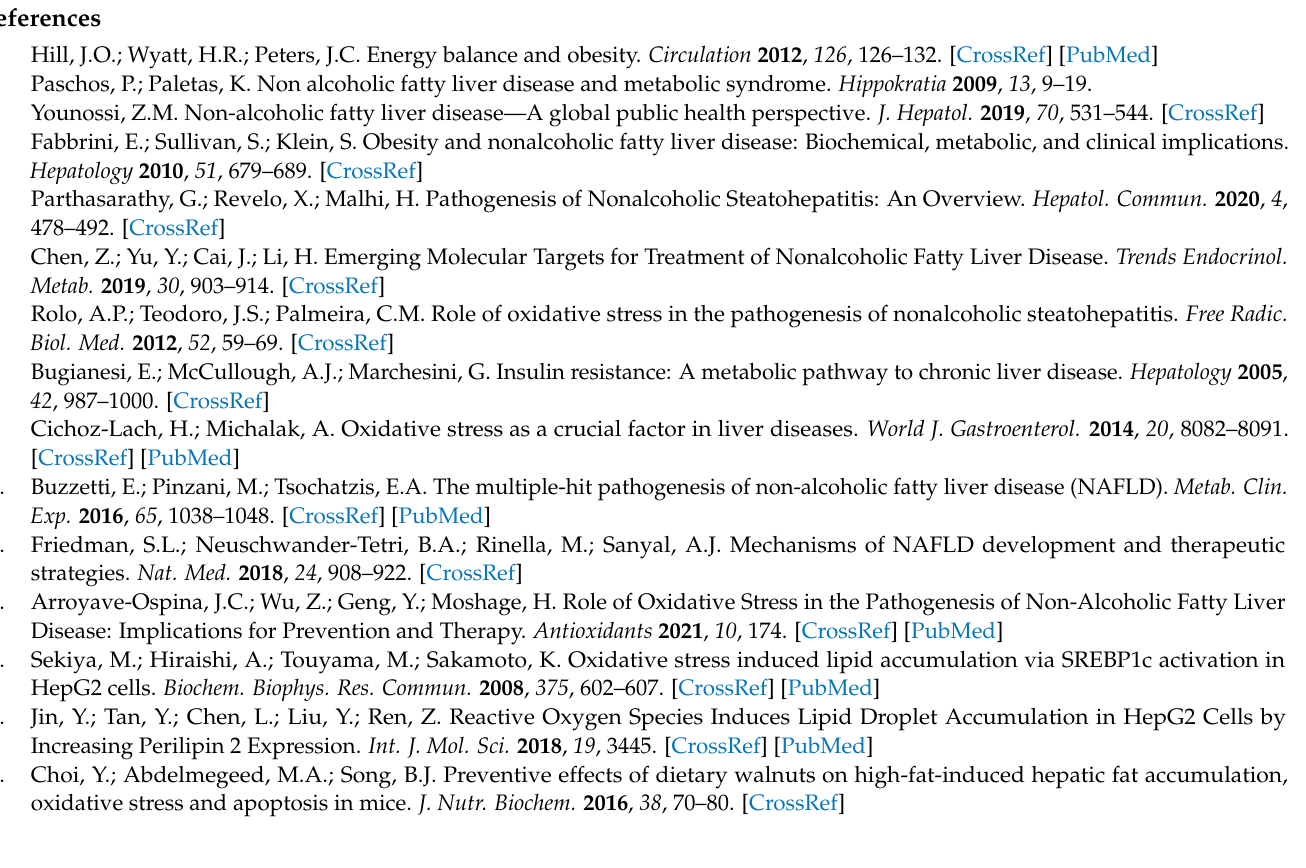
toxicity, Figure S2: Effect of Garcinia cambogia on FFA-induced hepatic steatosis, cell viability and ROS production in HepG2 cells for 48 h, Figure S3: Effect of Garcinia cambogia and HCA on HFD- and FFA-induced caspase 3 activation, Table S1: Primers for real-time